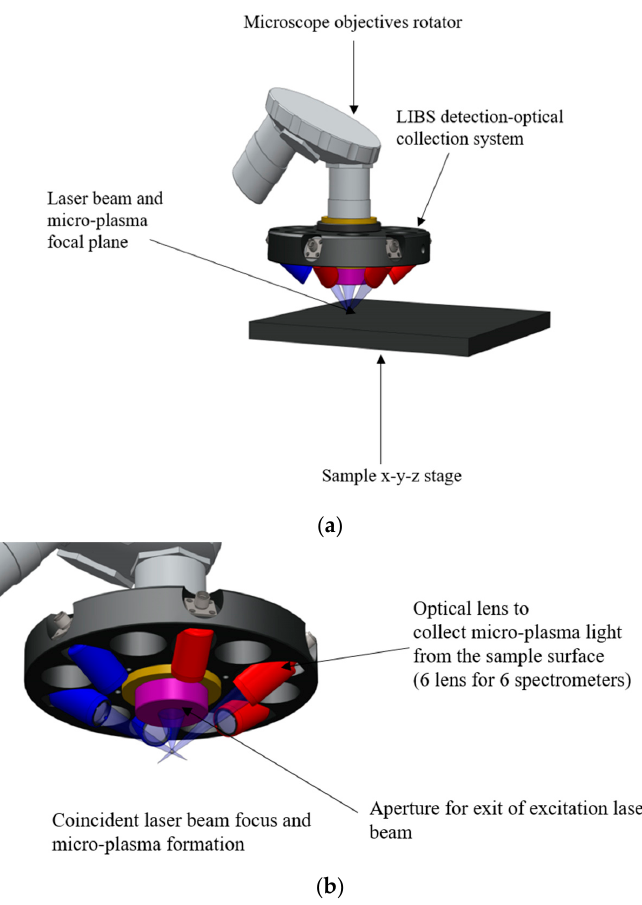
Figure 2. AutoCAD depiction of the optical collection system: ( a ) side view and ( b ) close-up from the bottom.